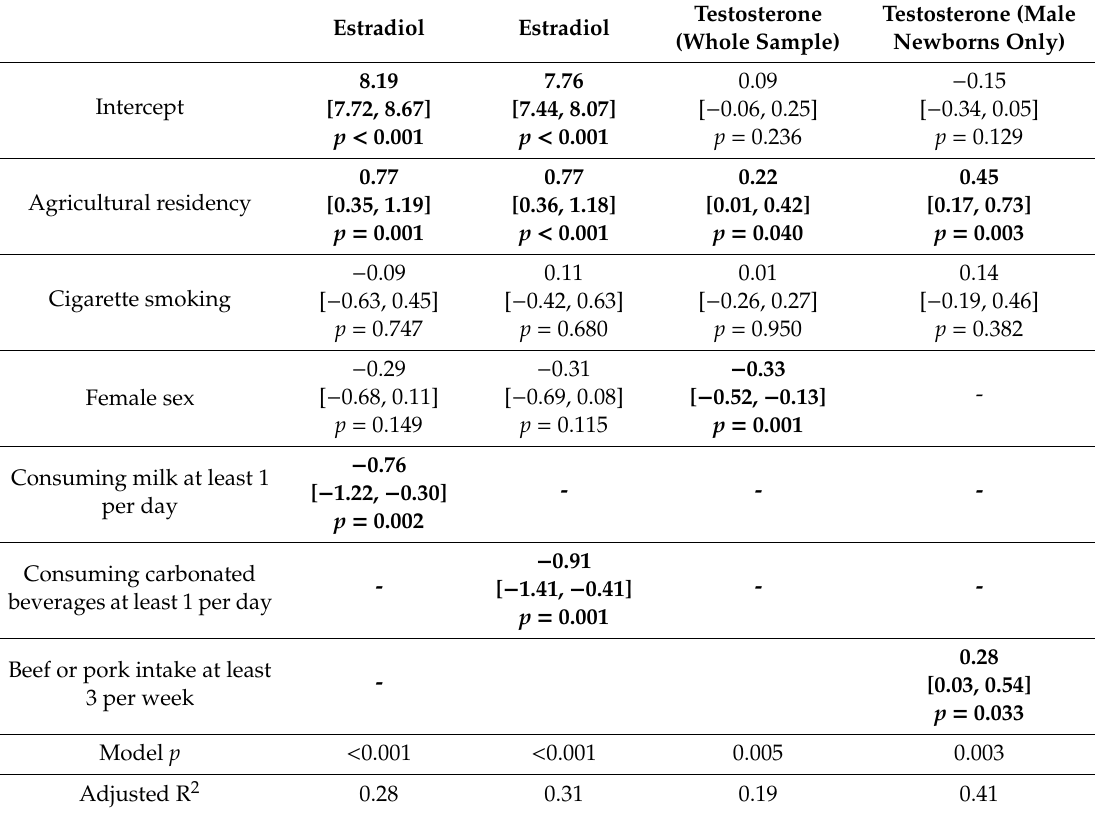
Table 3. Results of multivariate linear regression models in